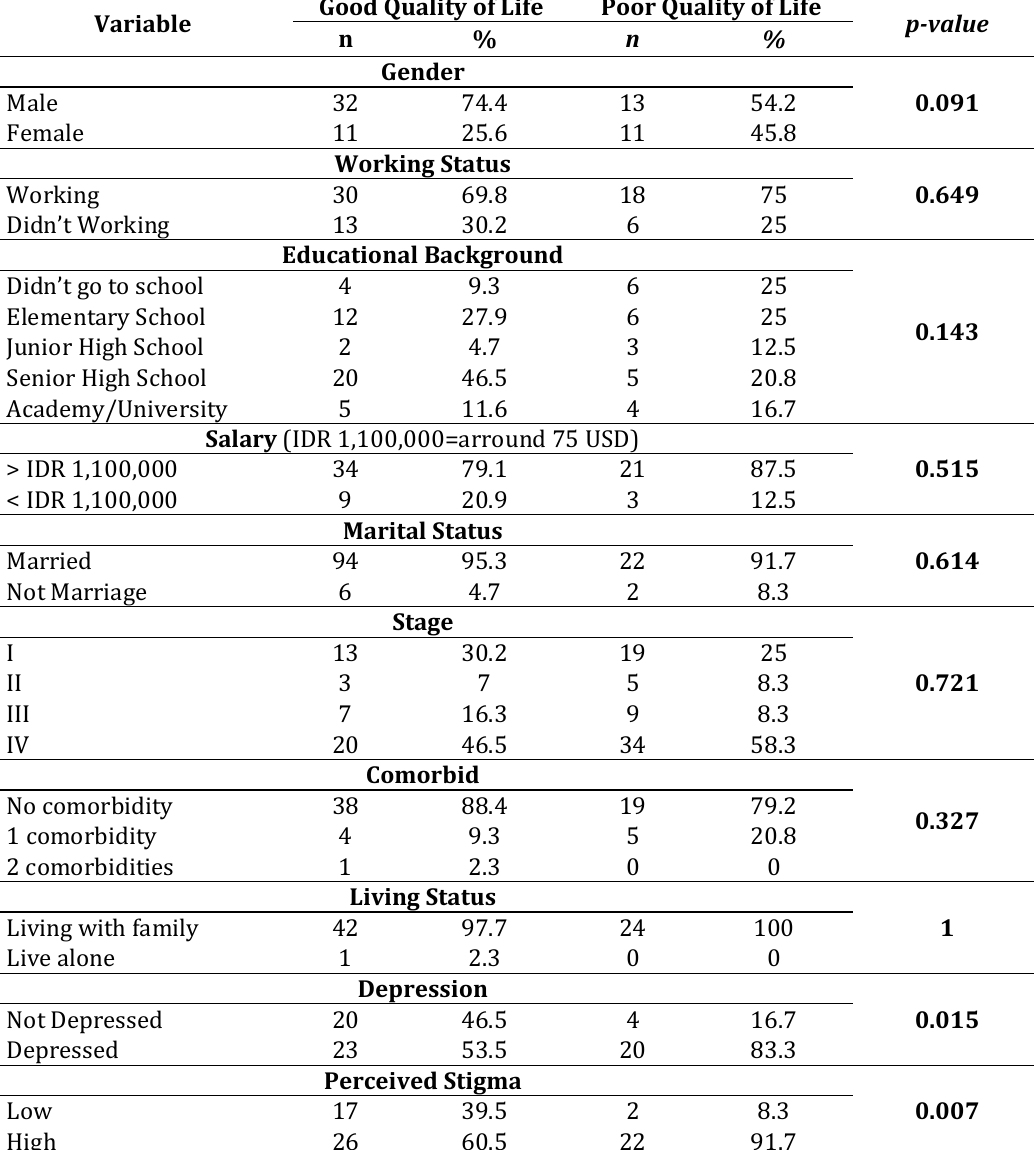
Participant’s demographic characteristic